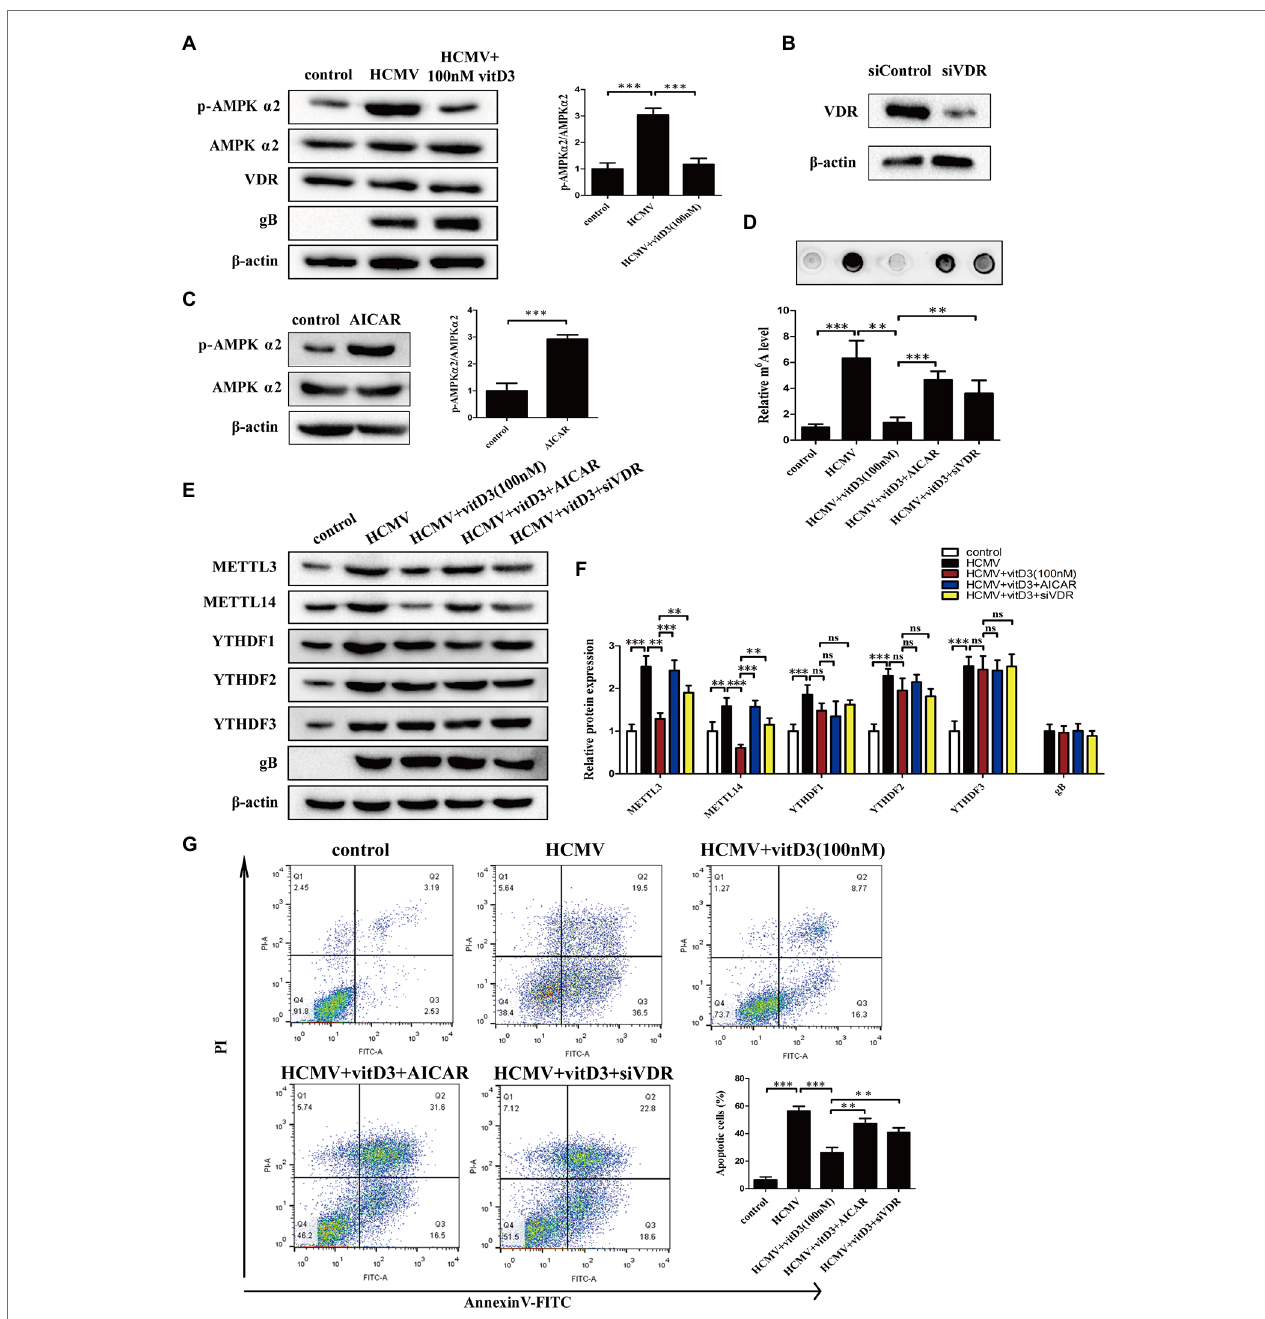
FIGURE 3 | Vitamin D3 inhibits HCMV-induced apoptosis and increased m6A methylation through the VDR/AMPK pathway. (A) The expression levels of p-AMPK α 2, total AMPK α 2, and VDR were detected by Western blotting in HAECs. Left, representative image of three independent experiments; right, statistical histogram representing the ratio of p-AMPK α 2 to total AMPK α 2. gB, a HCMV gene used to quantify HCMV infection. (B) Western blot analysis for knockdown efficiency of VDR in HAECs with siRNA (siVDR). (C) Western blot analysis to verify the effect of AMPK activator (AICAR) to increase p-AMPK levels. Left, representative image of triplicate experiments; right, statistical histogram representing the ratio of p-AMPK α 2 to total AMPK α 2. (D) RNA dot blot analysis verifies that vitD3 inhibits the HCMV-induced increase in total m6A levels through the VDR/AMPK pathway. HAECs were exposed to HCMV and simultaneously treated with vitD3 (100 nM) and AICAR (1 mM) for 4 days, or HAECs were transfected with siVDR for 12 h and then exposed to HCMV and vitD3. Top, representative images of RNA dot blot; bottom, statistical charts for quantification of RNA dots. (E) Representative Western blotting graphs verify that VitD3-induced alterations in m6A modification-associated proteins are via the VDR/AMPK pathway. (F) Histogram representing a densitometric analysis performed to quantify the relative intensity of the indicated bands detected by Western blotting. (G) Apoptosis rate detected by Annexin-V/PI-labeled flow cytometric assay in different treatment groups shows that vitD3 inhibits HCMV-induced apoptosis through VDR/AMPK pathway. Left, representative images of flow cytometry; right, statistical charts. All data are presented as the mean ± SD of triplicate experiments. Student’s t- test, ** p < 0.01 and *** p < 0.001. ns: no significant